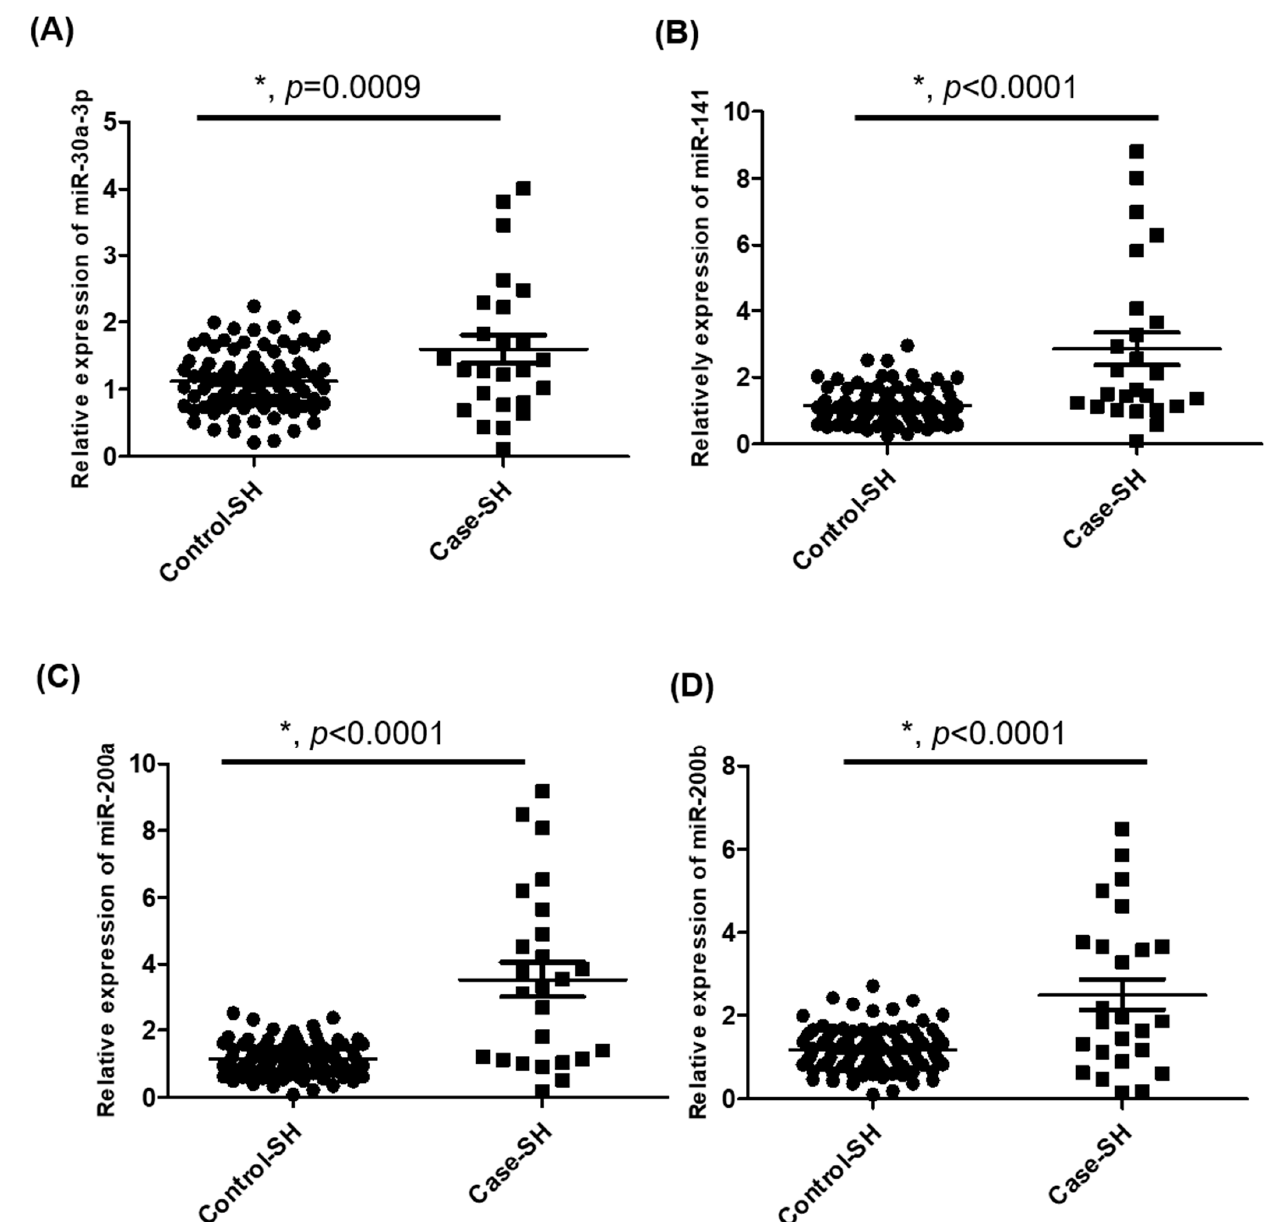
Figure 2. Differential expression of miRNAs in expanded cohort. ( A – D ) RT-qPCR results for miR-30a-3p, miR-141, miR-200a, and miR-200b levels, respectively, which were significantly higher in patients whose SH/CH-nonA progressed to EC (Case-SH) than in those whose did not (Control-SH). The expression of miRNAs was normalized to endogenous control miR-16. * p < 0.05.